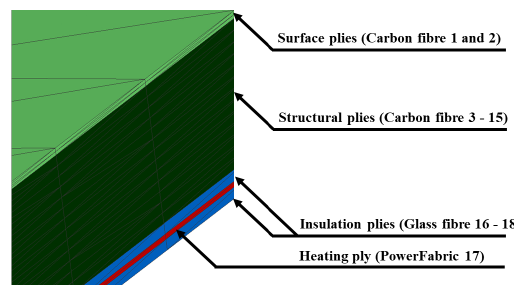
Figure 7: Coupon cut for the CTE testing cubes. Figure 8: Modelling of laminate plies in heat transfer simulation.